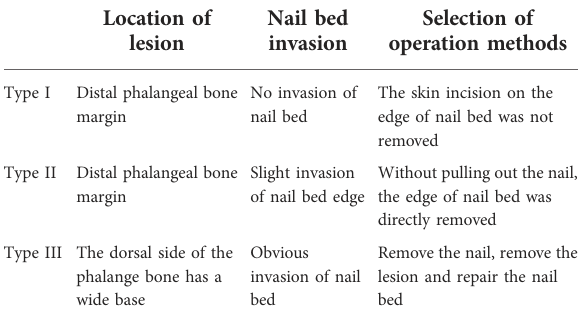
TABLE 1 Types of subungual